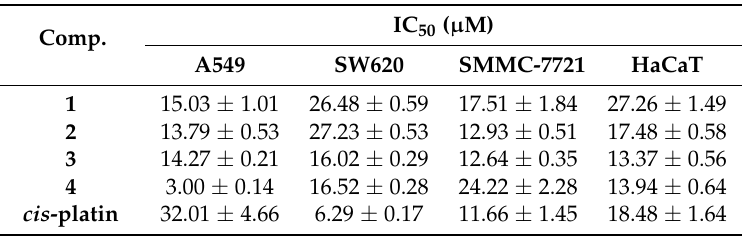
Table 2. The inhibitory effect IC 50 ( µ M) of the target complexes and cis -platin on human cancer cells and normal cells at 72 h.